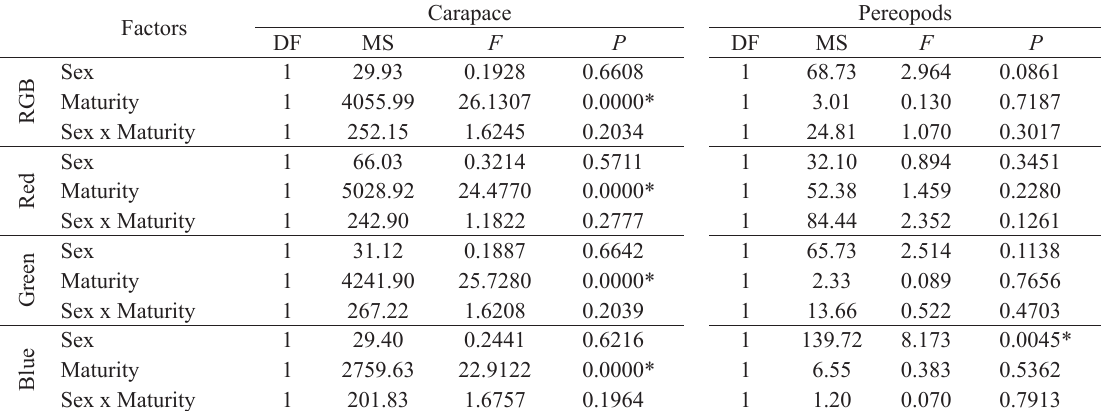
Comparison of the carapace and pereopods of Charybdis hellerii with the color spectra (RGB, red, green and blue) by two-way ANOVA; the first factor is the sex and the second is sexual maturity. DF = degrees of freedom,